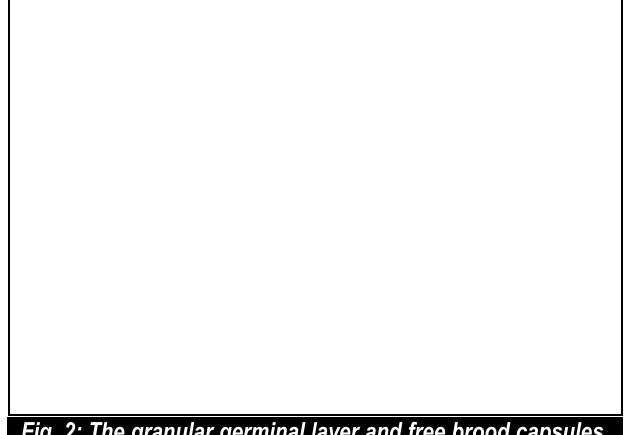
Fig. 2: The granular germinal layer and free brood capsules. Magnification x 40. Hematoxylin & Eosin